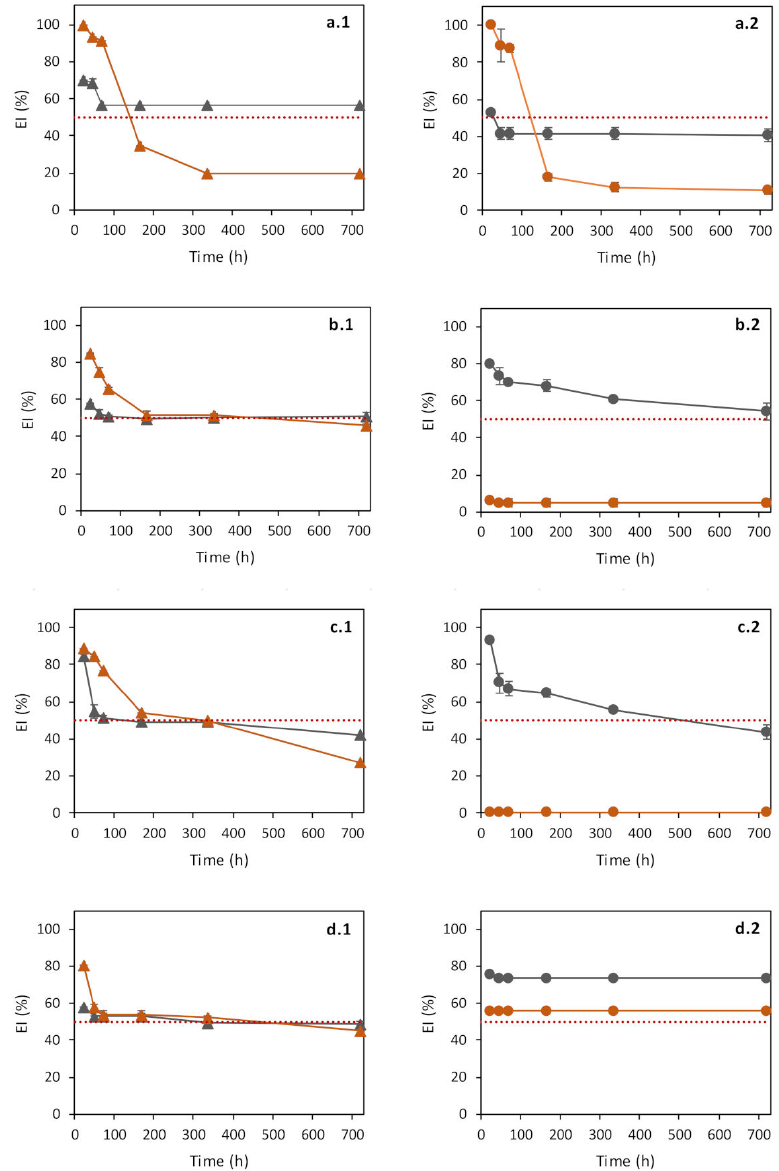
Figure 3. Emulsification index (EI%) overtime for emulsions prepared with FucoPol and different hydrophobic compounds: Castor oil ( a.1 , a.2 ), paraffin oil ( b.1 , b.2 ), almond oil ( c.1 , c.2 ) and olive oil ( d.1 , d.2 ), for FucoPol concentrations of 0.5 wt.% (gray) and 1.0 wt.% (orange), for o:w weight ratios of 2:3 (left) and 3:2 (right). The red dashed line represents EI (%) = 50. ( n =